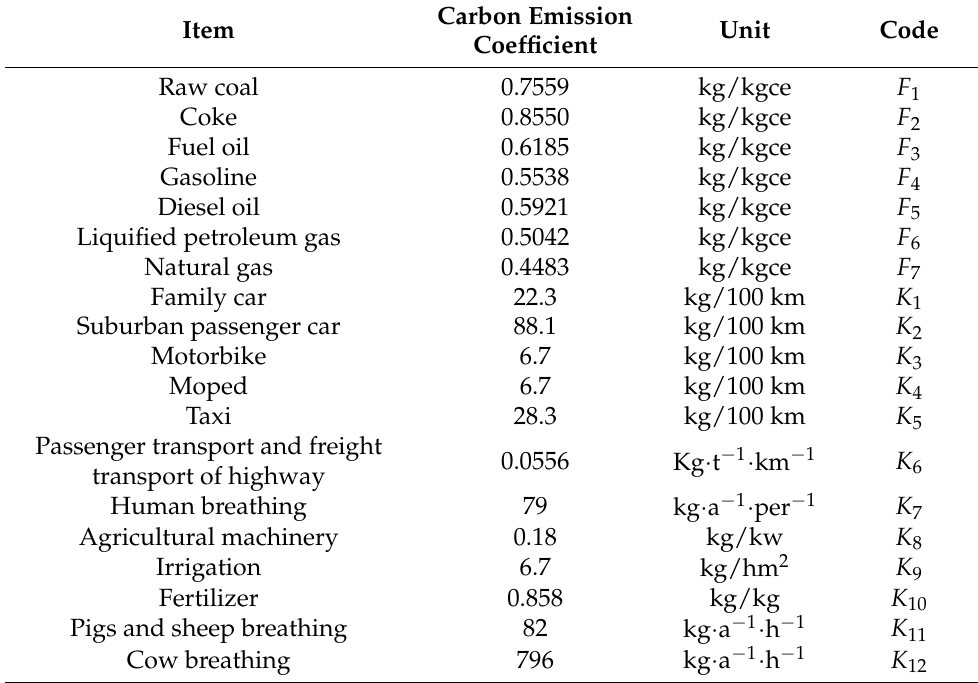
Table 1. Carbon emission coefficient of land use in the territorial space.